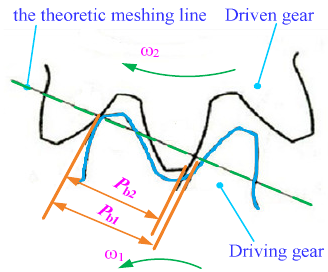
Figure 3. Mechanism of meshing impact.